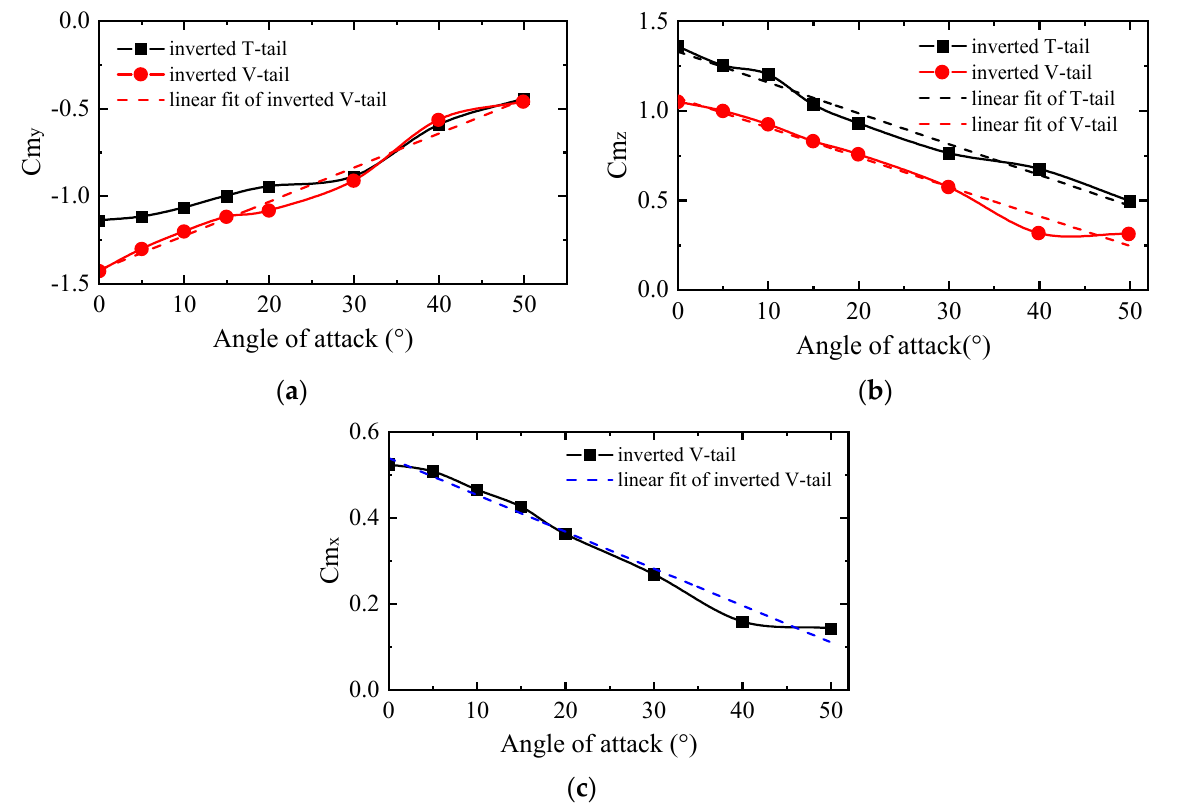
Figure 13. Moment coefficient at different angles of attack on tails. ( a ) Pitch moment coefficient. ( b ) Yaw moment coefficient. ( c ) Roll moment coefficient.